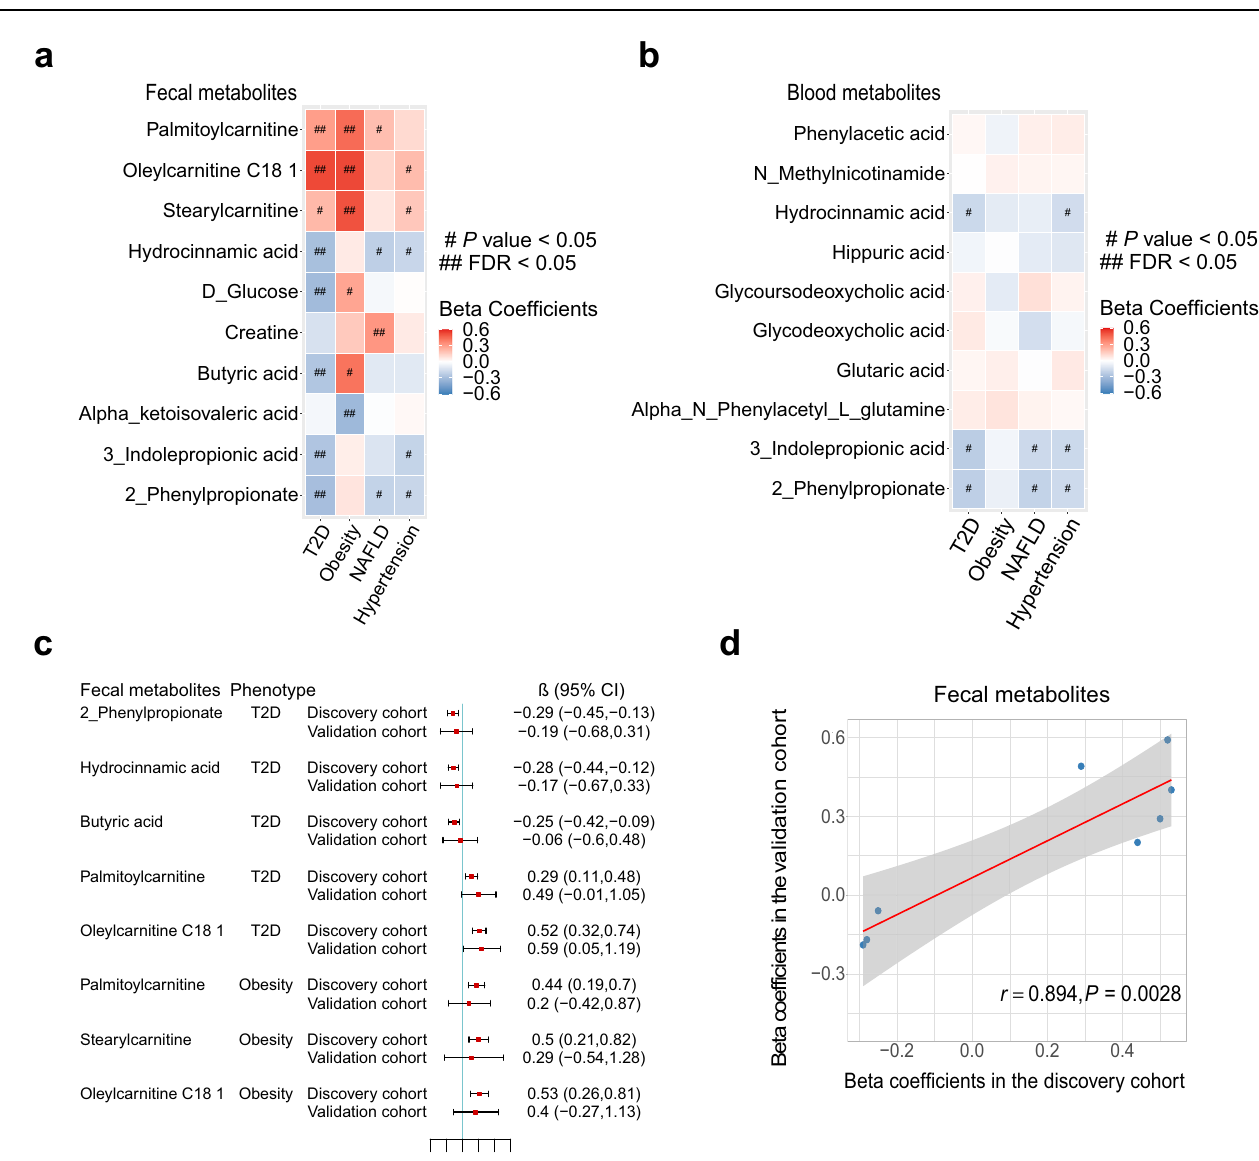
Fig. 4 | The associations of well-predicted fecal and blood metabolites with cardiometabolic diseases. a The associations of well-predicted fecal metabolites with cardiometabolic diseases. b The associations of well-predicted blood meta- boliteswithcardiometabolicdiseases.In a , b ,the intensity ofcolorsrepresentsthe partial regression coef fi cients that are computed by logistic models, adjusted by age, sex, smoking status, alcohol status, education, income, physical activity, and totalenergyintakeforobesity,andbyage,sex,BMI,smokingstatus,alcoholstatus, education,income,physicalactivity, and totalenergy intakefor T2D,hypertension and NAFLD. FDR is controlled by the Benjamini – Hochberg method. # P <0.05, ## FDR<0.05. c Replication of the signi fi cant associations of well-predicted fecal